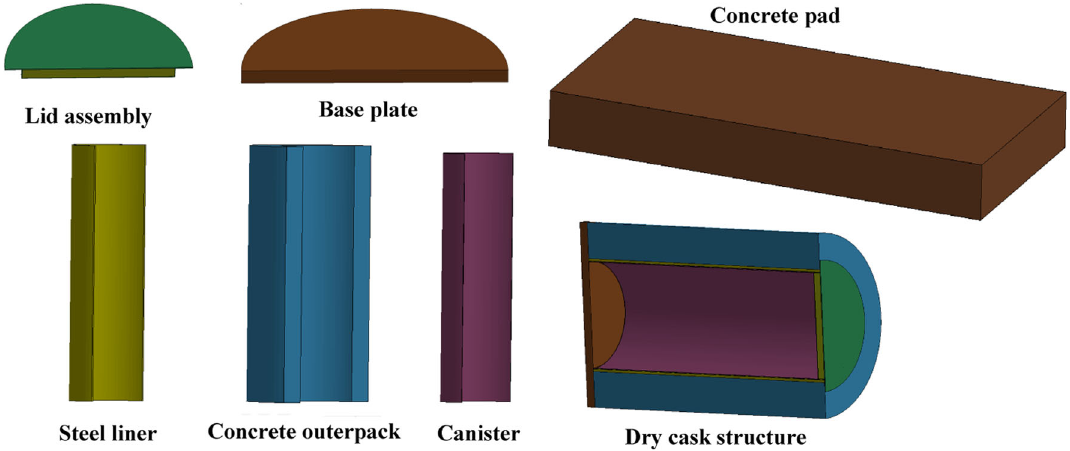
Fig. 12 Different parts of the